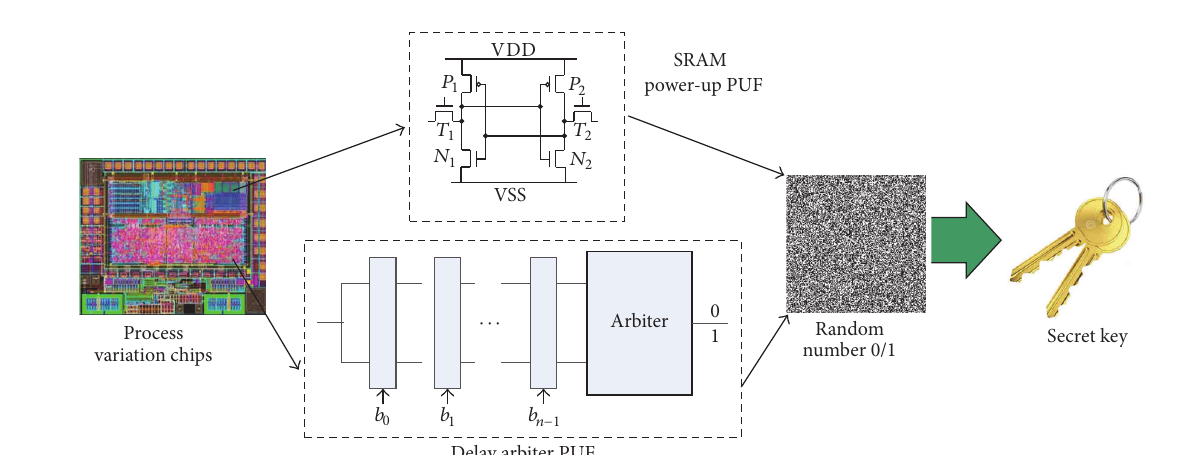
Figure 1: The IoT threats model.